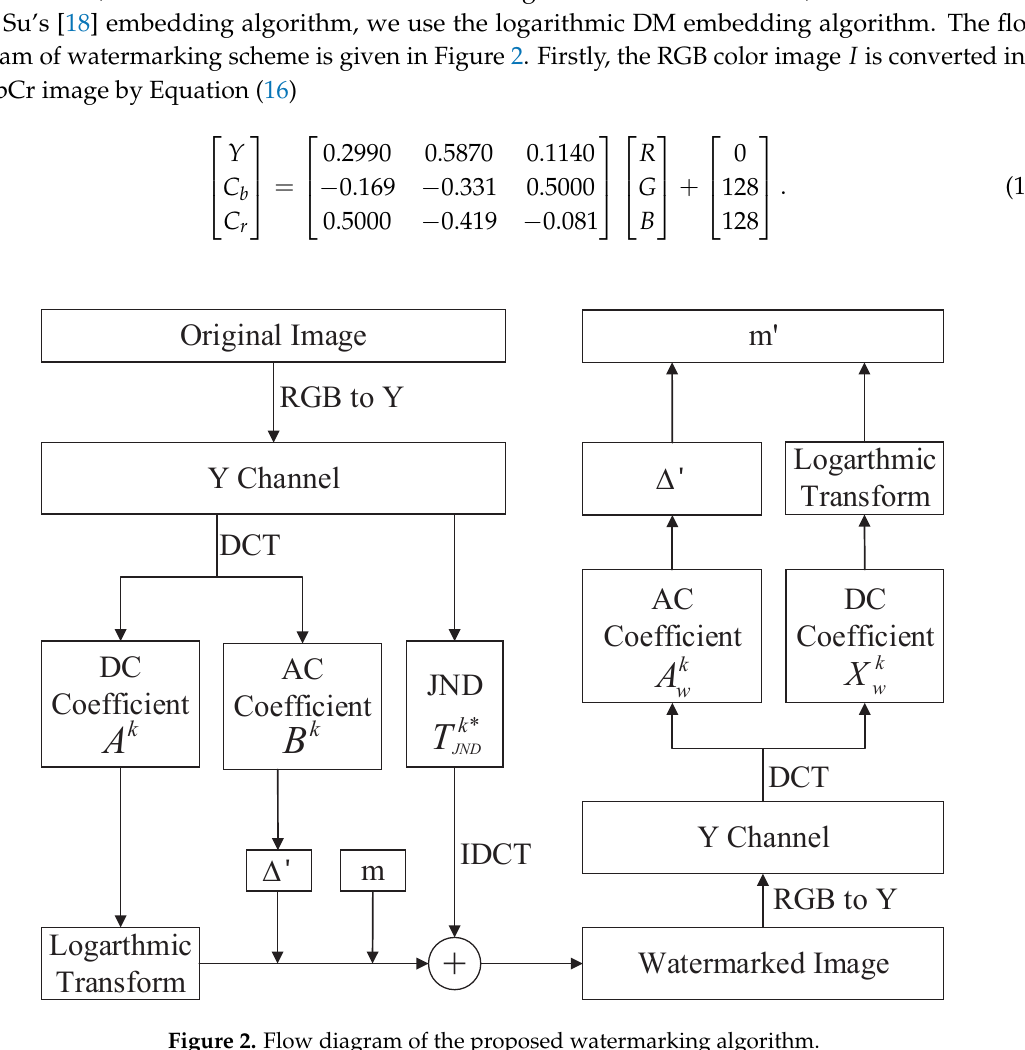
Figure 2. Flow diagram of the proposed watermarking